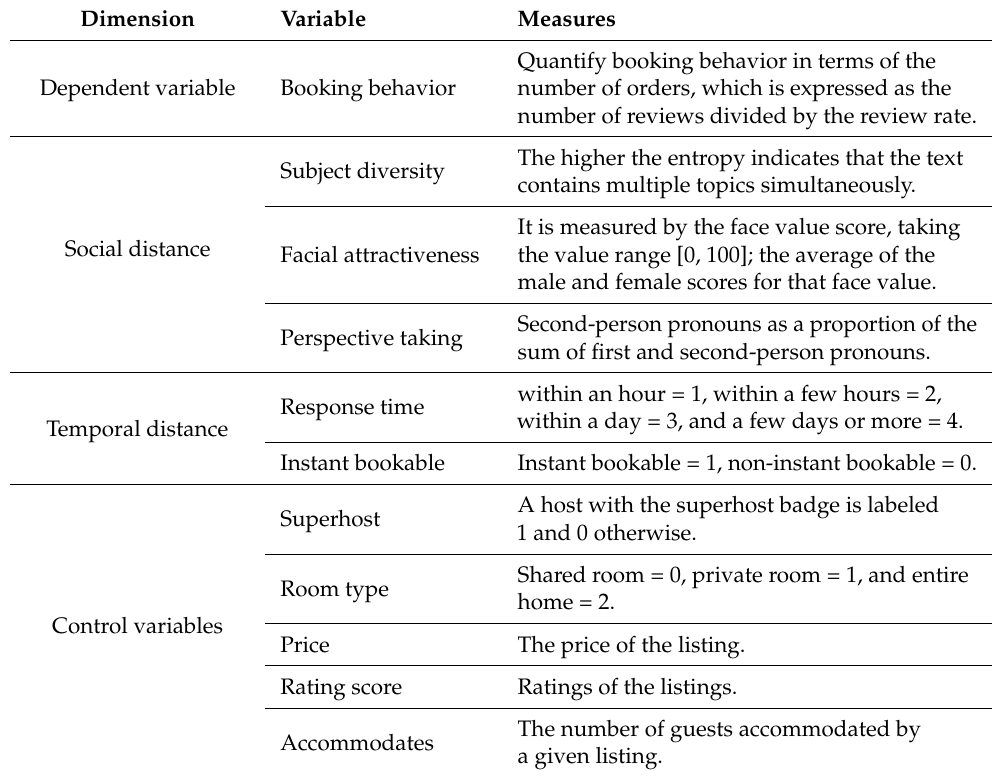
Table 2. Descriptions of